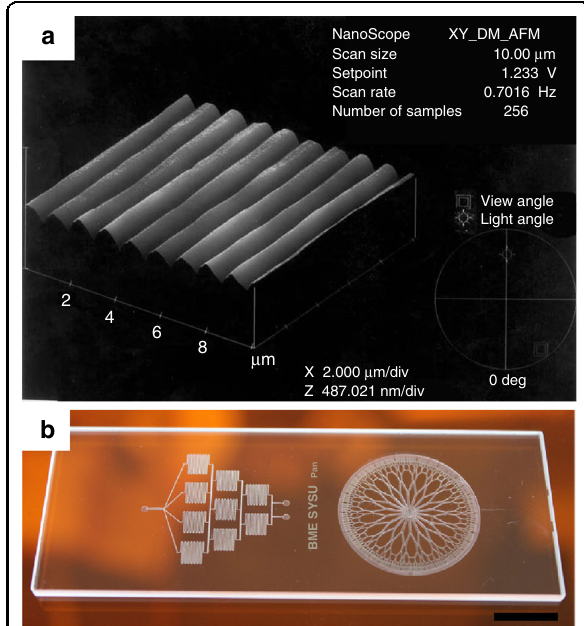
Fig. 4 Microstructuring of transparent substrates by LIPAA. a AFM images of a grating fabricated on fused silica using a KrF excimer laser and a phase mask 26 . The grating shows a period of 1.06 μ m and a clean and well-de fi ned structure without any severe damage. b Two micro fl uidic device patterns fabricated on